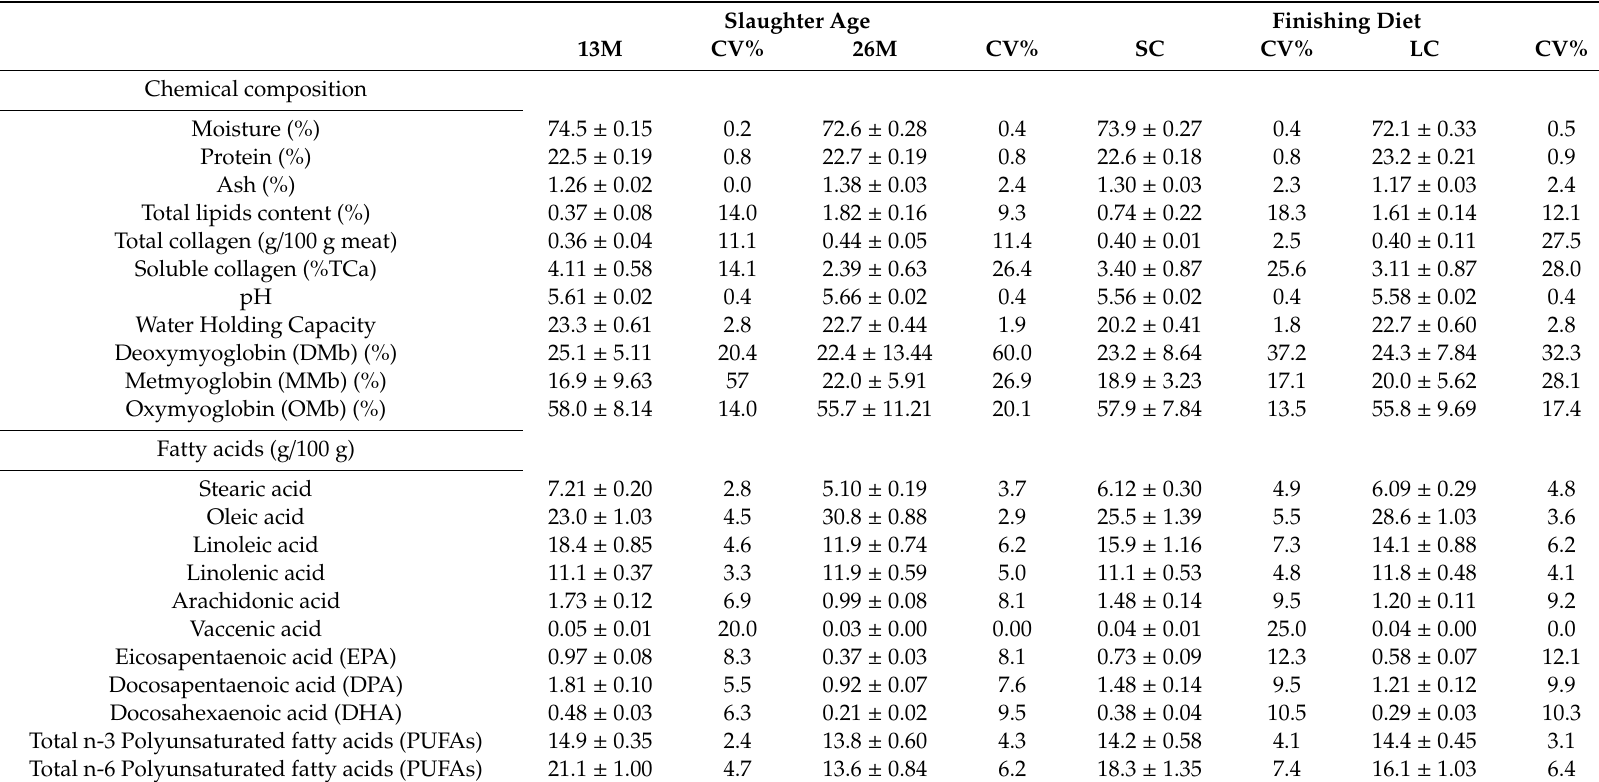
Table 1. Physicochemical and sensory description of Longissimus thoracis et lumborum muscle from Galician Mountain x Burguete crossbred foals slaughtered at 13 and 26 months of age (13M, 26M) and supplemented with standard and linseed concentrate (SC, LC) ( n = 46). Mean plus standard deviation and coe ffi cient of variation